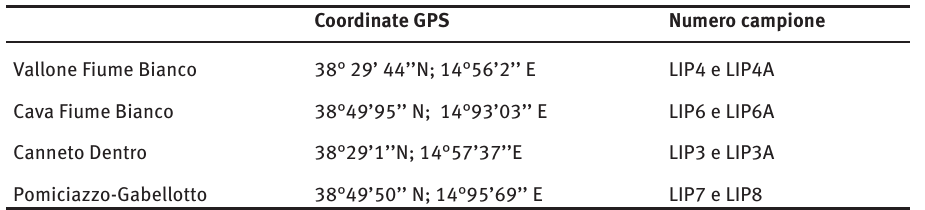
Table 1: Geological